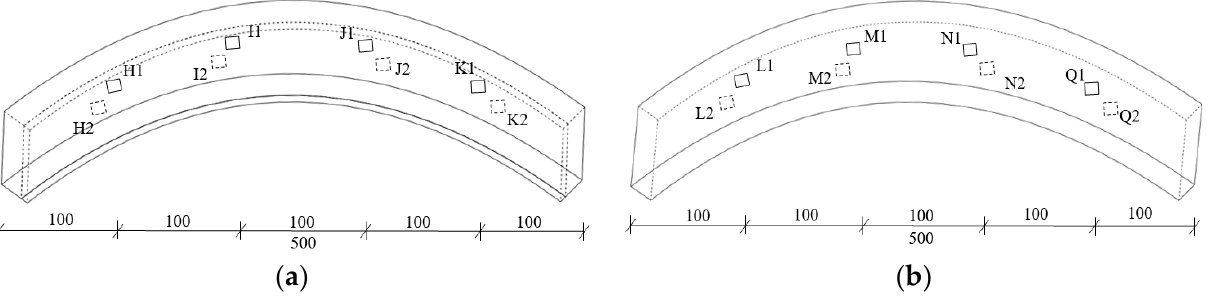
Figure 6. Position of strain gauges: ( a ) 3DPC thin-shell structure; ( b ) The traditional concrete shell structure.